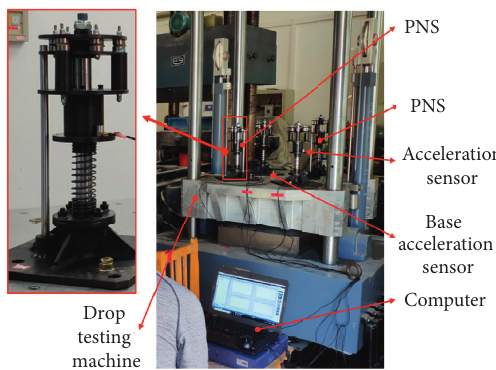
Figure 15: The shock testing